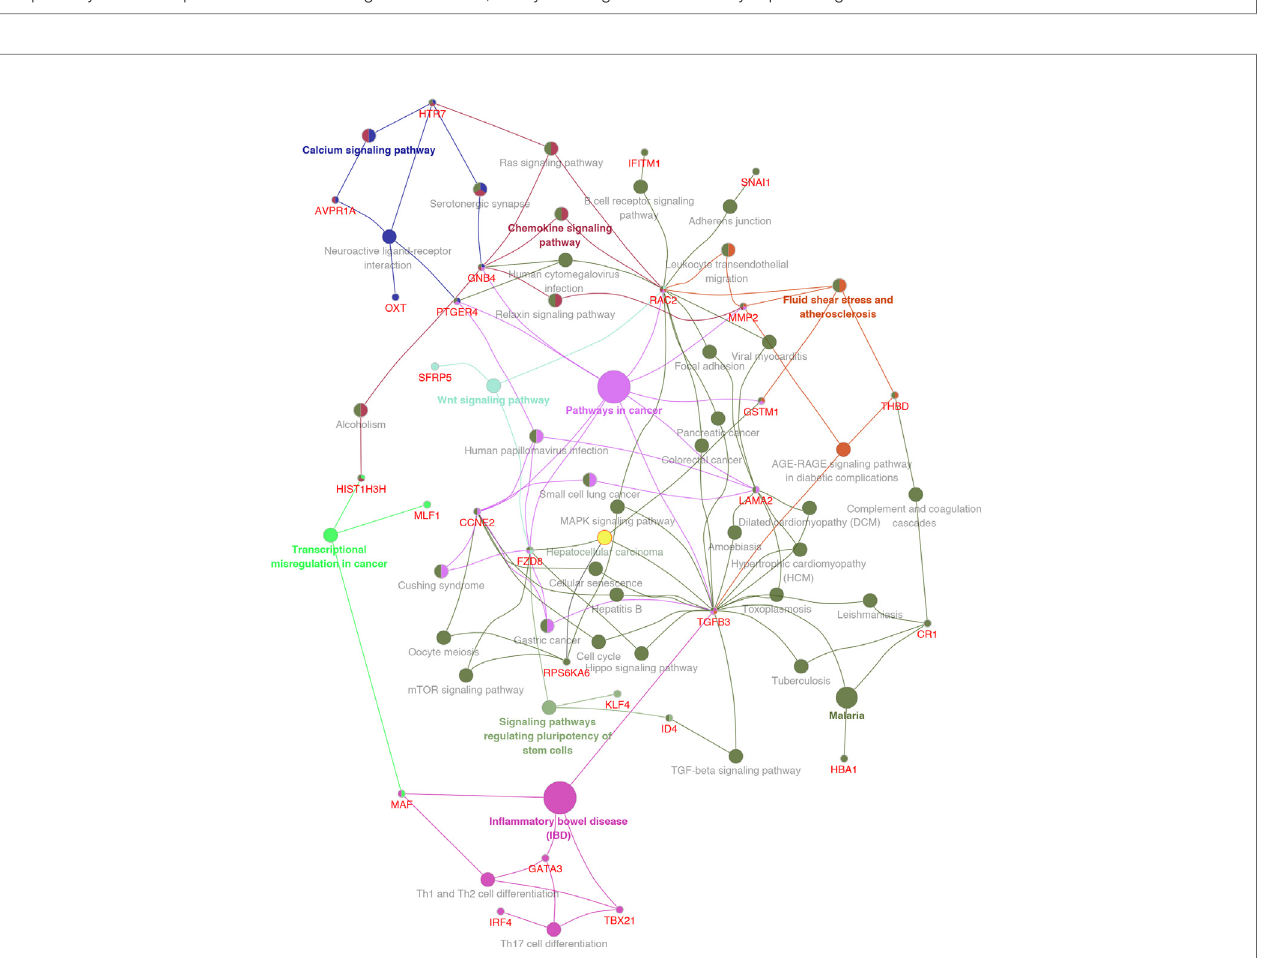
FIGURE 5 | KEGG pathway enrichment network diagram for MeDEGs. MeDEGs and enrichment pathways constitute a regulatory network. The larger the pathway circle, the more genes were enriched.